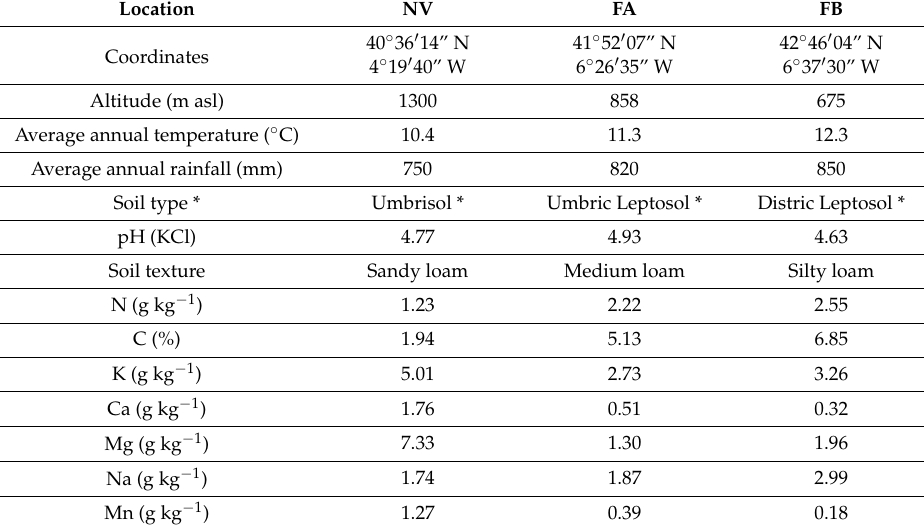
Table 1. Geographical, climatic, and soil characteristics in the selected study